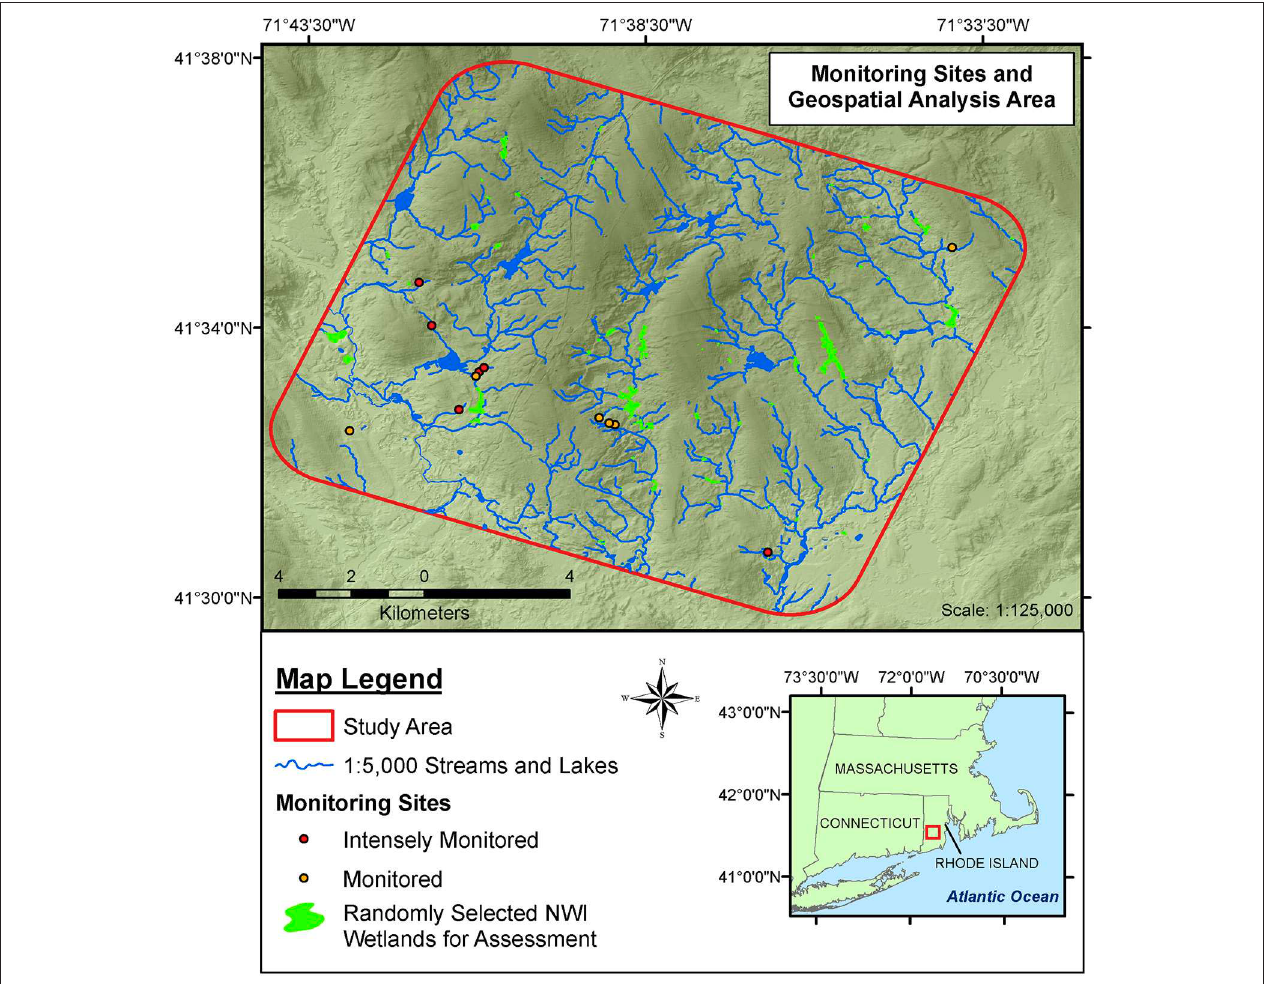
FIGURE 1 | Intermittent stream study sites and the National Wetland Inventory (NWI) wetlands examined for hydrological connections in geospatial analysis. All 12 intermittent stream locations were monitored to determine hydroperiods and wetland attributes. Six of those intermittent streams were used for assessment of whole-reach gross nitrate-N uptake during baseflow conditions, transient storage modeling, and microbial